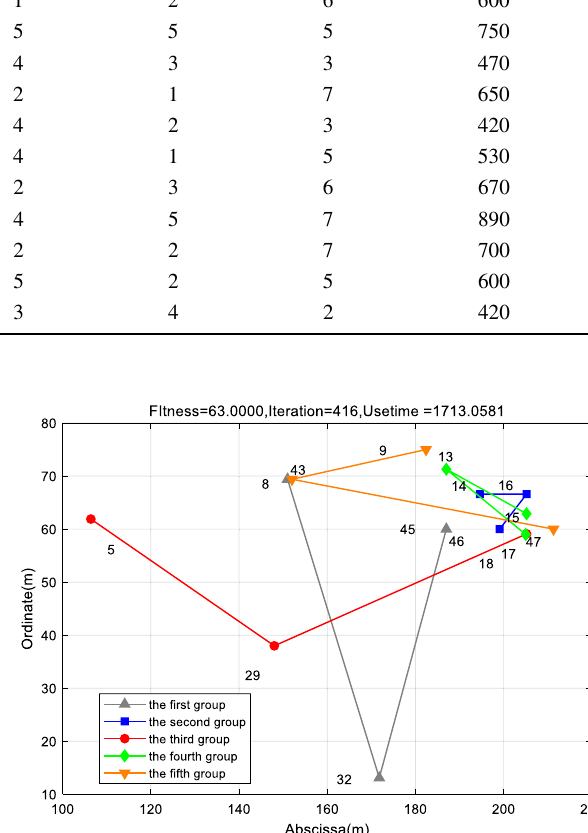
Fig. 7 Comparison of the evolution curve of optimal fitness on quo- tient model The gray, blue, red, green and orange lines in the figures above correspond to the maintenance paths of five mainte- nance personnel, respectively. The positive triangle, square, circle, diamond and inverse triangle, respectively, represent the nodes that each maintenance personnel repairs.